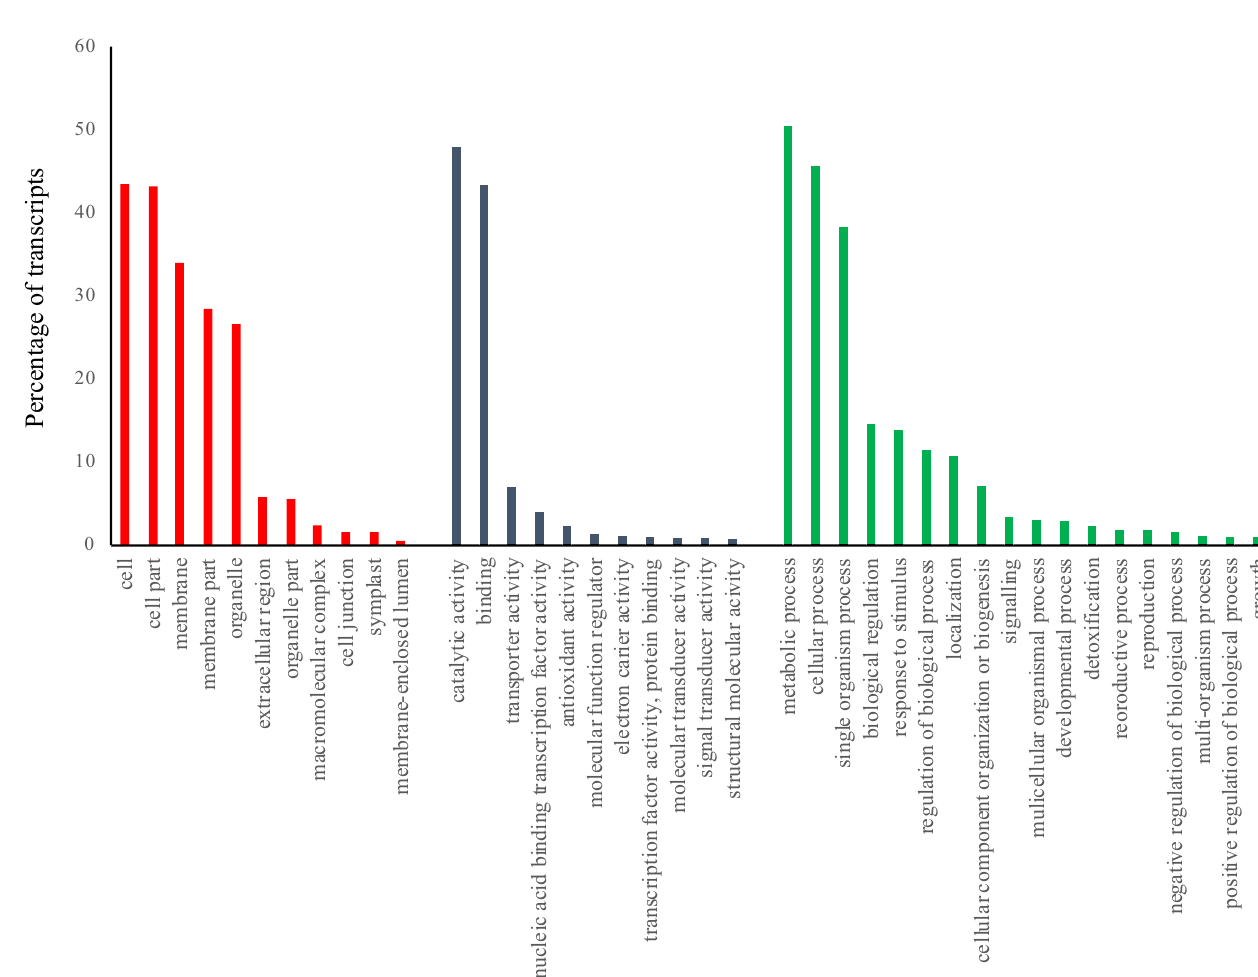
Fig 2. GO classification of DEGs based on sequence homology to 3 main categories of cellular component, molecular function and biological process.